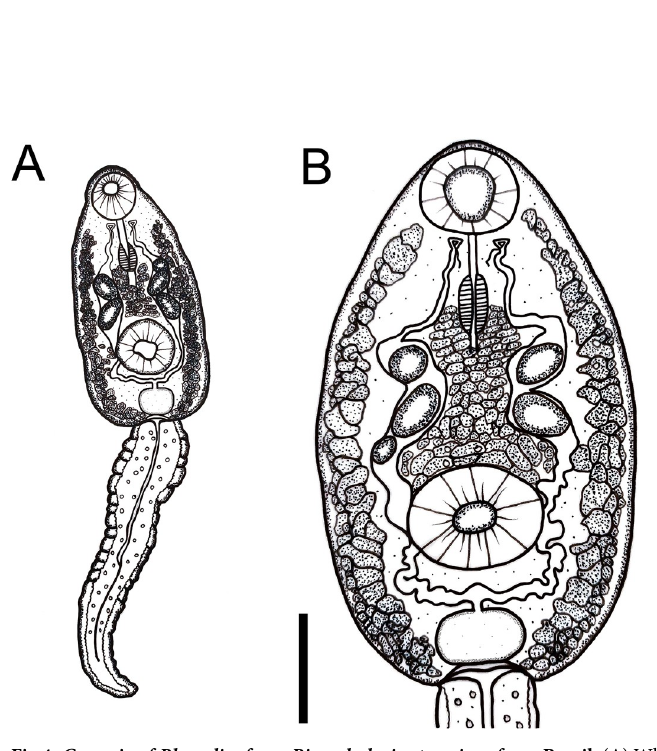
Fig 4. Cercaria of Rhopalias from Biomphalaria straminea from Brazil. (A) Whole view. (B) Detail of body. Cercariae from the same infected snail were genetically identified as Rhopalias sp. 1. Scale bars: 50 μ m.